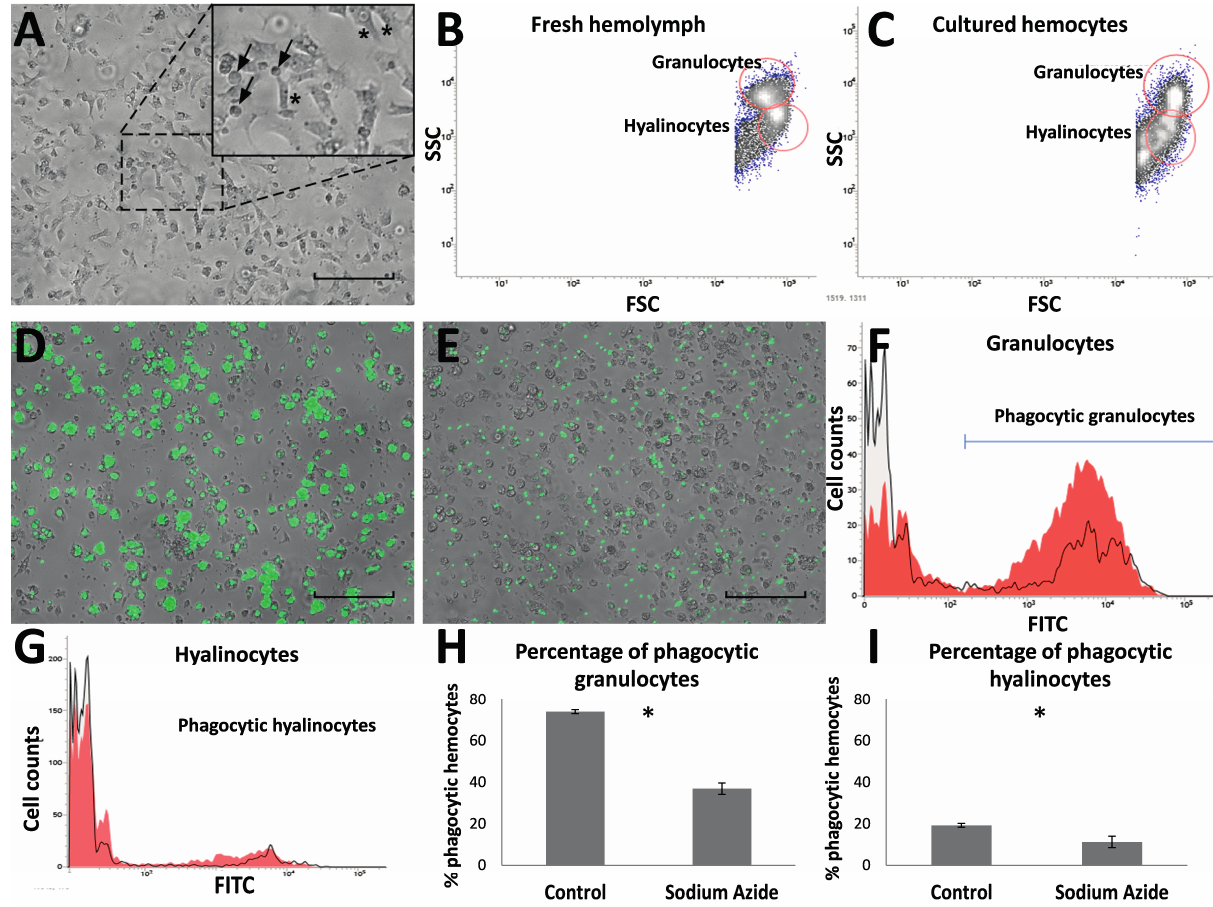
Figure 1. Characterization of Mytilus chilensis hemocytes in primary cell culture. ( A ) Light microscopy image. Insert: Granulocyte-type hemocytes (asterisks) and hyalinocyte-type hemocytes (arrows), Scale bar = 100 μ m; ( B , C ) Flow cytometry analyses of fresh ( B ) and cultured ( C ) hemocytes showing both granulocyte-type and hyalinocyte-type hemocytes appearing in the red circles; ( D ) Fluorescence microscopy image of phagocytosis assay on hemocytes incubated with 0.2% FITC-labeled zymosan (green) for 1 h, Scale bar = 100 μ m; ( E ) Inhibition of phagocytosis with 2% sodium azide, Scale bar = 100 μ m; ( F , G ) Phagocytosis of 0.2% FITC-labeled zymosan after 1 h observed in granulocytes ( F ) and hyalinocytes ( G ). The red lines correspond to phagocytosis of control hemocytes, and the overlaid black lines correspond to phagocytosis of hemocytes incubated with sodium azide showing inhibition; ( H , I ) Effect of 2% sodium azide on the phagocytic activity of granulocyte-type ( H ) and hyalinocyte-type ( I ) hemocytes. Bars represent the mean ± standard errors ( n = 4). * p <